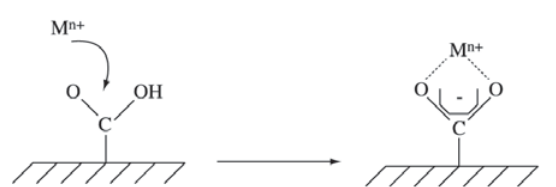
Scheme 1. Cation exchange mechanism with the carbon surface carboxylic